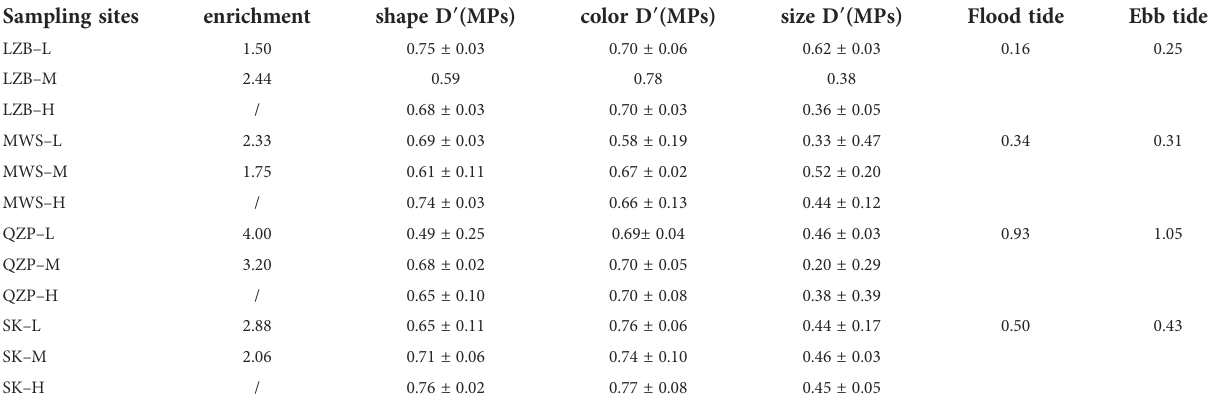
TABLE 1 Microplastic (MP) shape, color, size diversity indices ( M ± SD) in studied mangrove forests ( M ± SD) and the current velocity at the fl ood and ebb tides (cm/s). Sampling